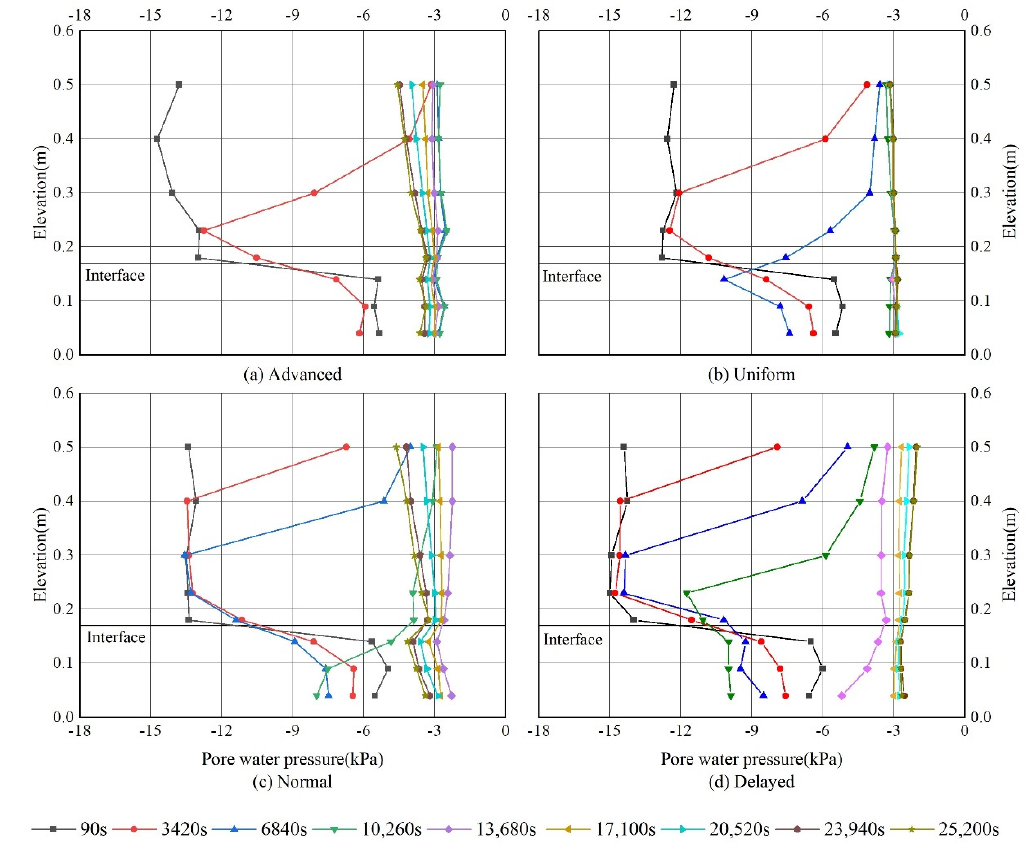
Figure 11. Pore water pressure profiles under relatively long rainfall duration. ( a ) Advanced, ( b ) Uniform, ( c ) Normal and ( d ) Delayed.